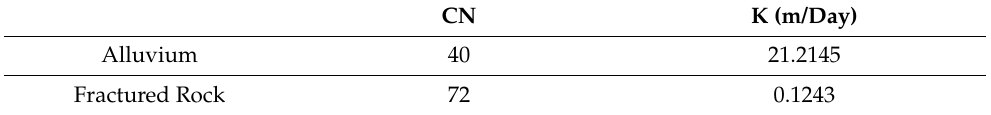
Table 4. Hydraulic conductivity of the alluvium and fractured rock based on the CN value. CN K